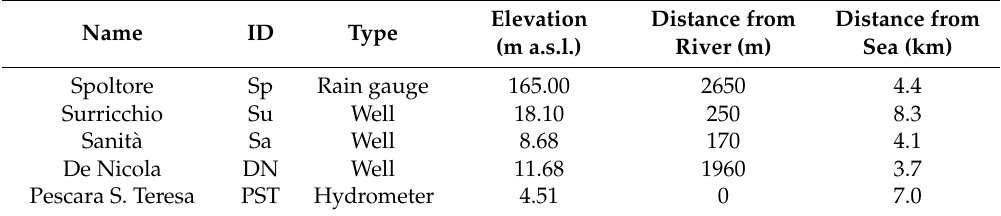
Figure 1. ( Top ) The study area; and ( Bottom ) the hydrogeological framework and the monitoring network are shown (see Table 1 for initials and abbreviations). Table 1. Topographical data and type of monitored sites.